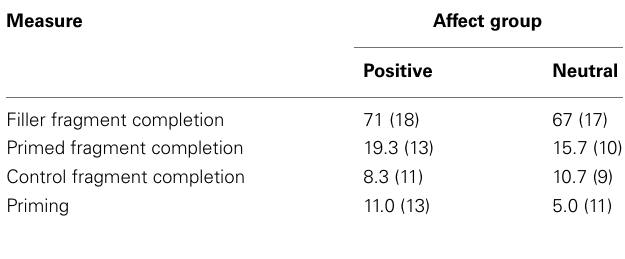
Table 1 | Mean percentage completion (SD) on the fragment completion task.